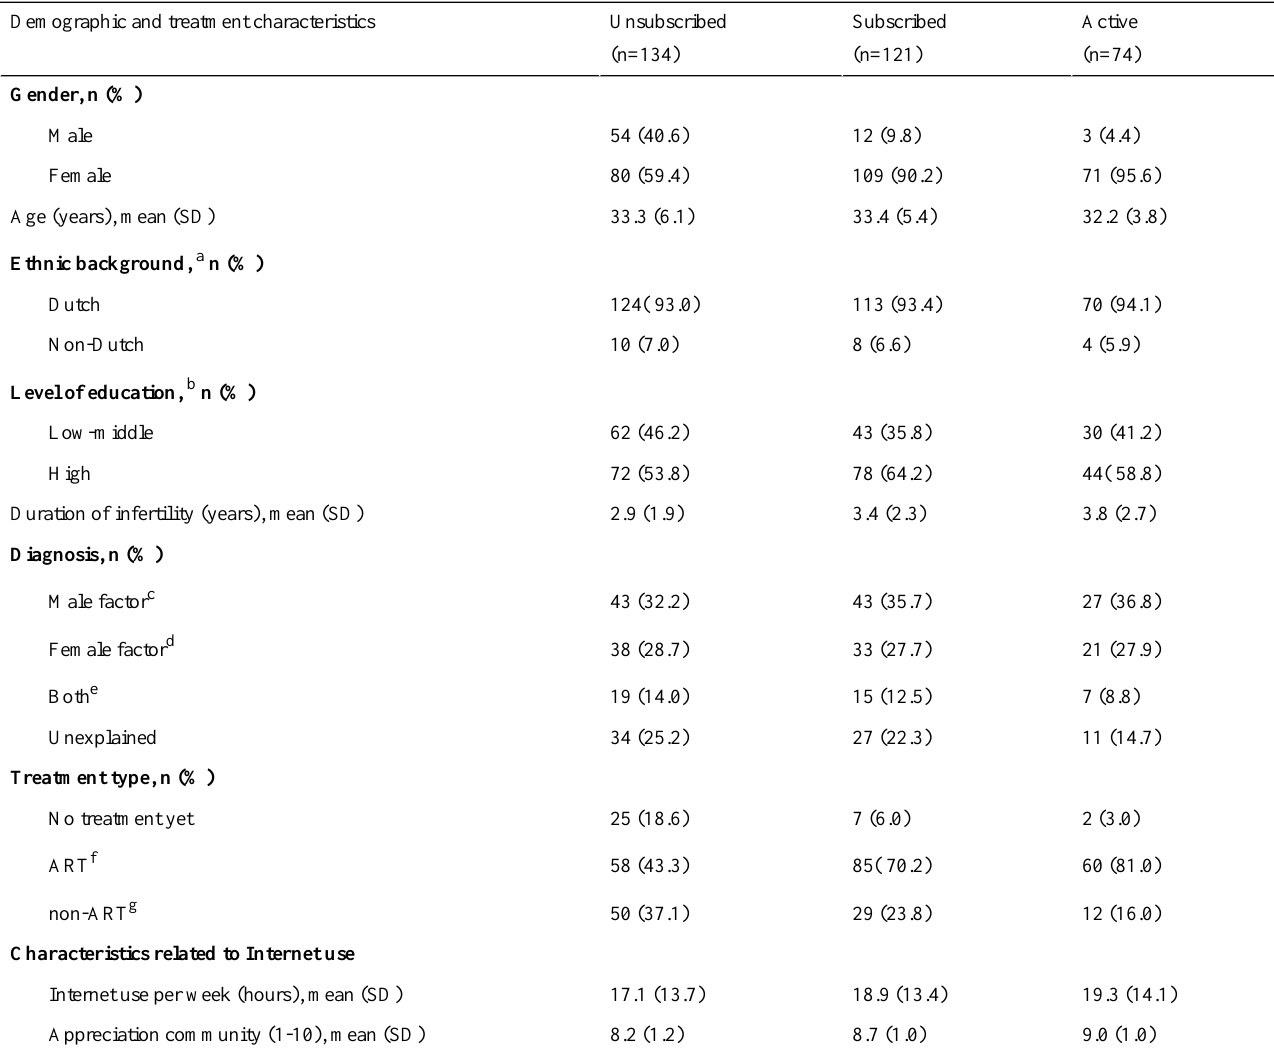
Table 2. Participants’background characteristics divided in three groups (unsubscribed, subscribed, and participation